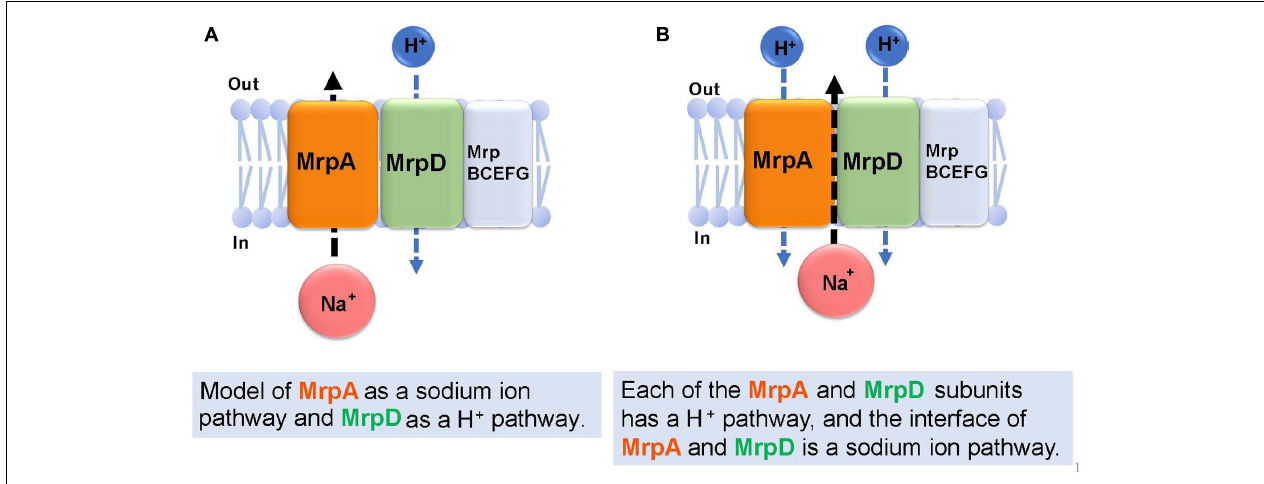
FIGURE 6 | Ion transport pathway model of the Mrp antiporter. Based on previous studies, there are two kinds of ion transport models for the Mrp antiporter. The first model (A) proposes MrpA as a Na + pathway and MrpD as a H + pathway (Moparthi et al., 2011). The second model (B) proposes that each of the MrpA and MrpD subunits has a H + pathway, and the interface of MrpA and MrpD is a Na + pathway (Sazanov,